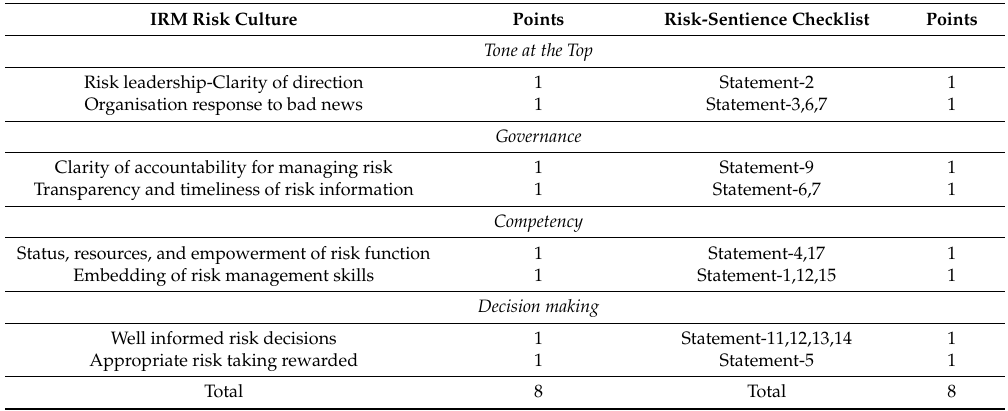
Table 2. Integration of key IRM (Institute of Risk Management) Risk Culture indicators into the Risk-Sentience Fertility Checklist.